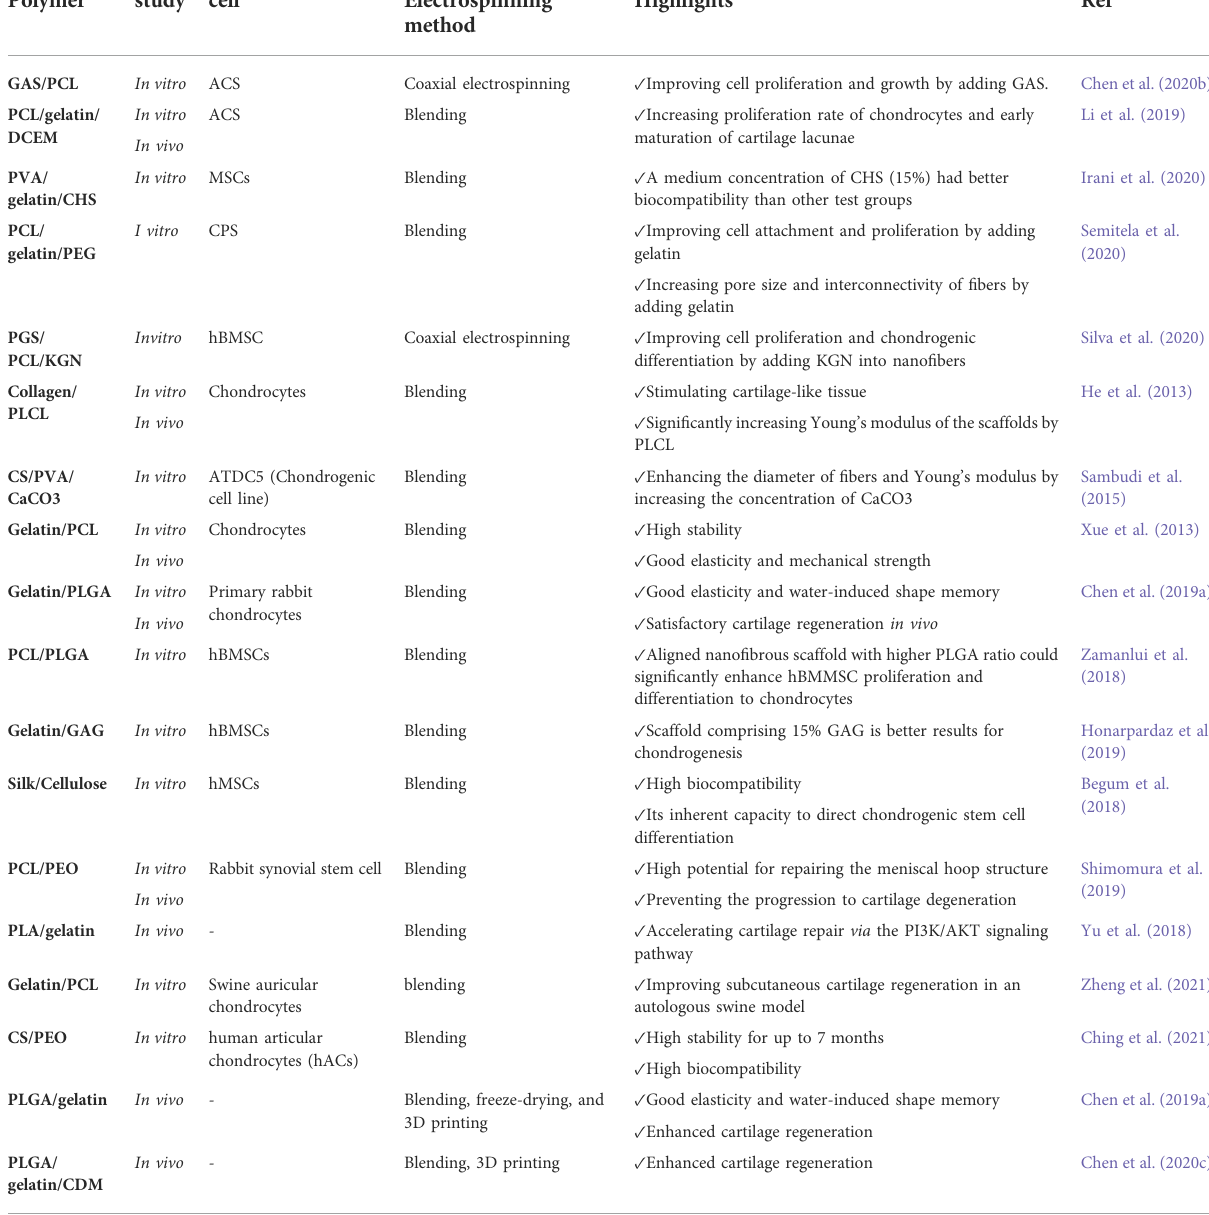
TABLE 5 An overview of electrospun hybrid nano fi ber for cartilage tissue engineering.